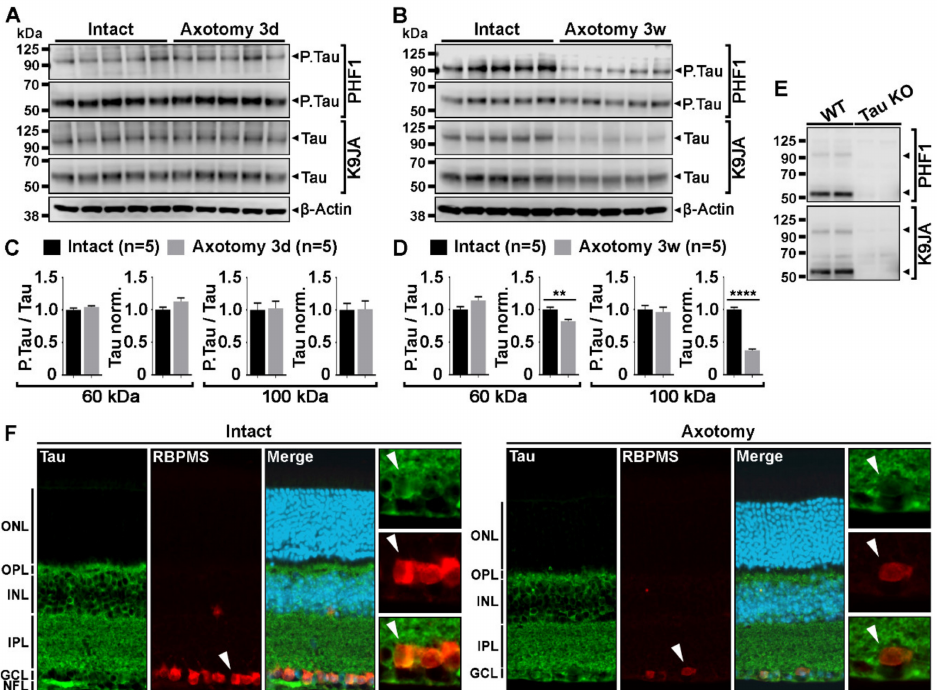
Figure 1. Tau protein down-regulation is associated with retinal ganglion cell death after optic nerve lesion. ( A , B ). Western blot analysis of phospho-Tau (P.Ser396 and P.Ser404) and Tau protein expressions in whole mouse retinal lysates at 3 days (3 d) and 3 weeks (3 w) after optic nerve injury ( n = 5 mice per group). Injuries were carried out in the left eye. The right intact eye was used as control. Phospho-Tau and Tau expression were detected with PHF1 and K9JA antibodies, respectively. β -actin was used as loading control. ( C , D ). Quantitative analysis of injury-induced changes in Tau and phospho-Tau expression. Phospho-Tau expression was normalized to total Tau expression. Tau expression was normalized to β -Actin levels. Phospho-Tau and Tau expressions were normalized to the intact values (right eye). Densitometry analysis was performed for the bands at ~60 and ~100 kDa. The quantification showed no di ff erence in phospho-Tau and Tau expression in retina at 3 days after optic nerve crush. However, after 3 weeks, Tau expression was significantly decreased. ( E ). Western blot analysis of phospho-Tau and Tau antibody specificity in Tau KO retinal lysates. ( F ). Immunofluorescent localization of injury-induced Tau protein down-regulation in RBPMS-labeled RGCs. Abbreviations: ONL = Outer Nuclear Layer, OPL = Outer Plexiform Layer, INL = Inner Nuclear Layer, IPL = Inner Plexiform Layer, GCL = Ganglion Cell Layer, NFL = Nerve Fiber Layer. Scale bars: 50 µ m, close-up: 20 µ m. Data are expressed as mean ± S.E.M. Statistics: Student’s t-test, **: p < 0.01, ****: p <